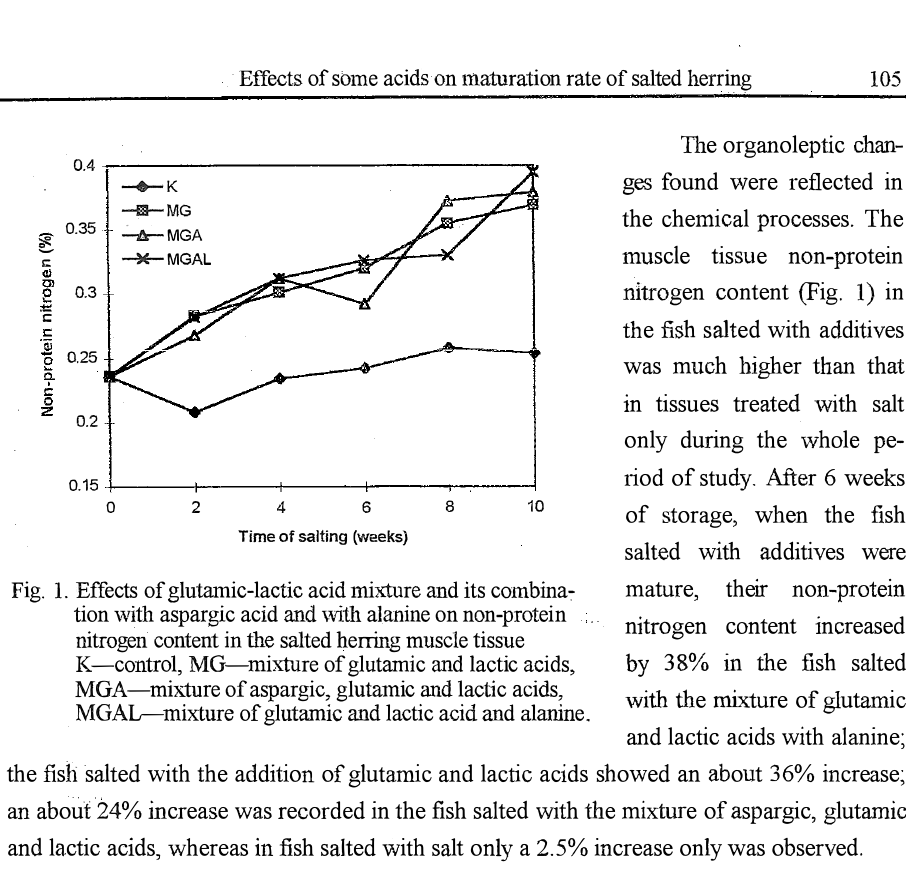
Results of pair-wise comparisons with Student's t-test non-protein nitrogen content in the herring carcasses muscle tissue salted v,ith glutamic-lactic acid mo..'ture and its combination with